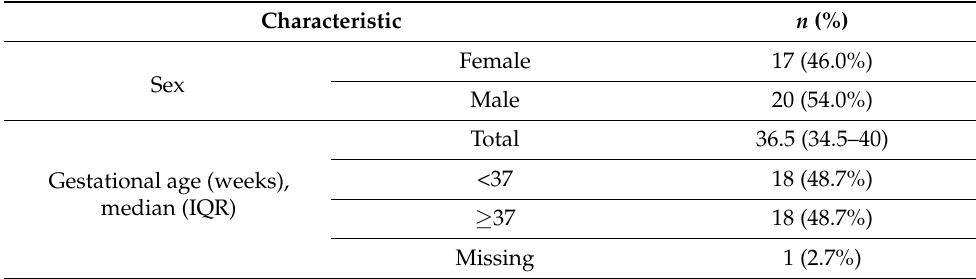
Table 1. Neonates demographics ( n =